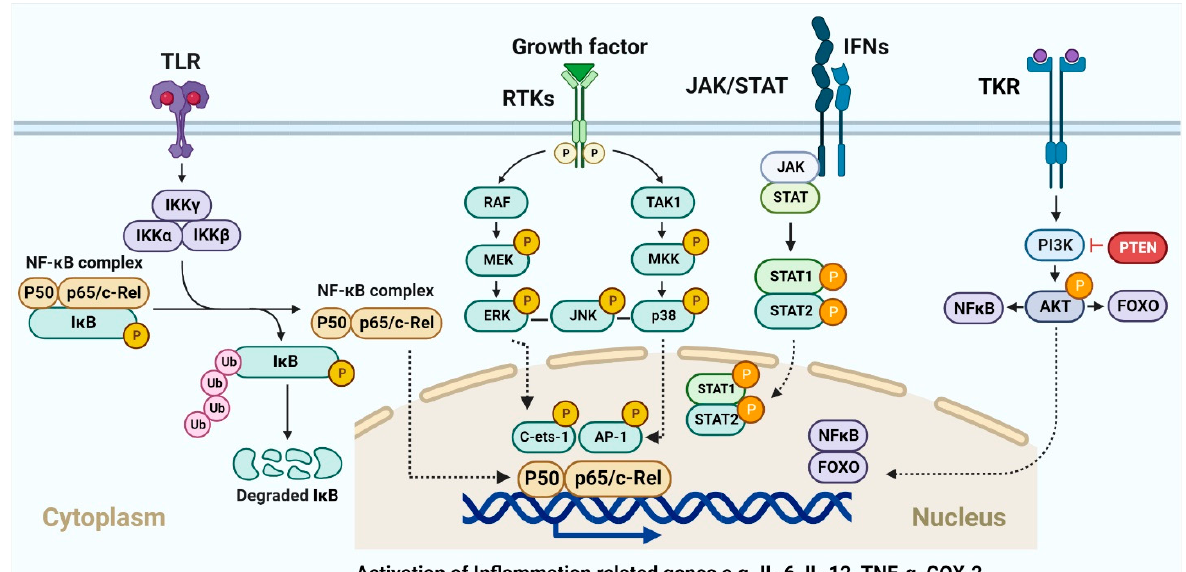
Figure 5. Inflammation and tumor progression mechanisms involving signaling pathways. Various membrane receptors trigger intracellular signaling pathways that contribute to processes including inflammation and tumor growth. Numerous well-understood pathways, including NF- κ B, MAPK, JAK-STAT, and PI3K-AKT, are activated by subsequent downstream signaling events. These mech- anisms control a wide range of inflammatory variables.